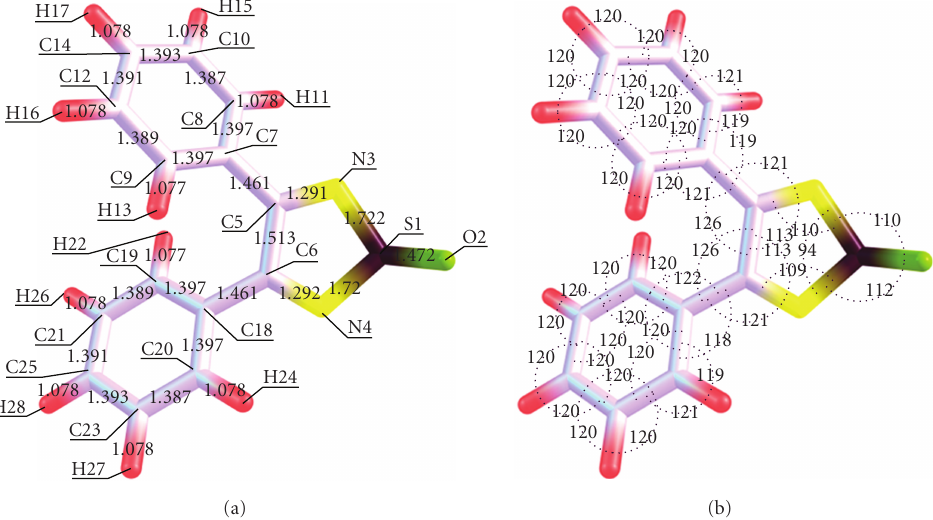
Figure 1: Interatomic bond distances ( ˚A) and bond angles (deg) for 3,4-diphenyl-1,2,5-thiadiazole 1-oxide.